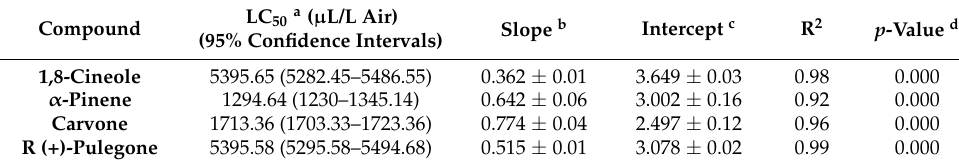
Table 1. Lethal concentration (LC 50 ) values for the individual monoterpenes. Compound